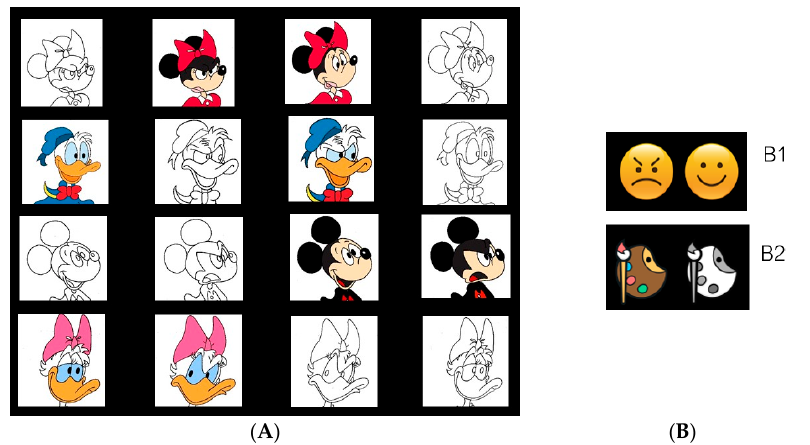
Figure 1. Stimuli ( A ) and cue ( B ) used in the emotional task-switching (note: B1 = cue used in the Valence task; B2 = cue used in the Color task). The stimuli were modified.